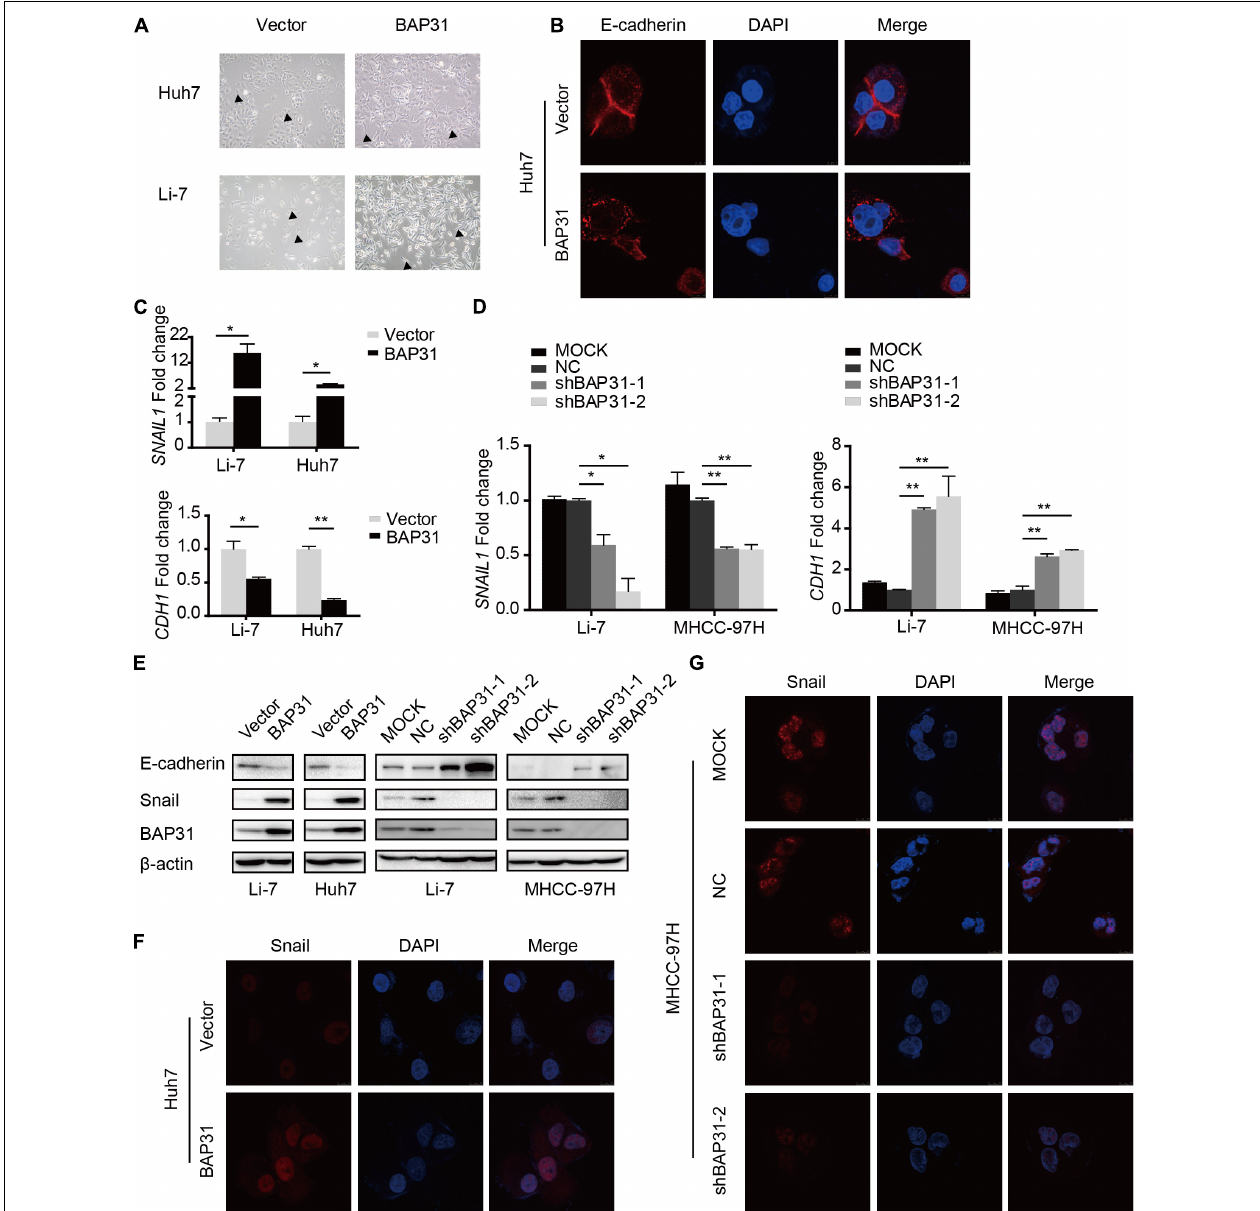
FIGURE 4 | BAP31 induced Snail-mediated EMT process. (A) Morphological observations in Huh7 and Li-7 cells with BAP31 over-expression. Arrows pointed to the representative cell morphology. (B) Immunofluorescent (IF) assays were performed in Huh7 cells with BAP31 over-expression, which contained antibody against E-cadherin (red) and conjugated Alexa 568 secondary antibody, DAPI (blue) was used as the marker of nuclear. (C) Fold change of Snail ( SNAIL1 ) and E-cadherin ( CDH1 ) mRNA expression in Li-7 and Huh7 cells with BAP31 overexpression. Results were presented as mean ± SD and t -test was conducted between vector and BAP31 group ( n = 3, * p < 0.05, ** p < 0.01). (D) Fold change of Snail ( SNAIL1 ) and E-cadherin ( CDH1 ) mRNA expression in Li-7 and MHCC-97H cells, which were divided into four groups: MOCK, NC, shBAP31-1, shBAP31-2. Results were presented as mean ± SD and t -test was conducted between NC and shBAP31-1/-2 group ( n = 3, * p < 0.05, ** p < 0.01). (E) Western blot analysis showing protein expression of E-cadherin, Snail and BAP31 in HCC cells with over-expression and knockdown of BAP31. (F) Immunofluorescent (IF) assays were performed in Huh7 cell with BAP31 over-expression, which contained antibody against Snail (red) and conjugated Alexa 568 secondary antibody, DAPI (blue) was used as the marker of nuclear. The merge was referred to the overlay of Snail and DAPI. (G) Immunofluorescent (IF) assays were performed to test the nuclear contents of Snail in MHCC-97H cells with BAP31